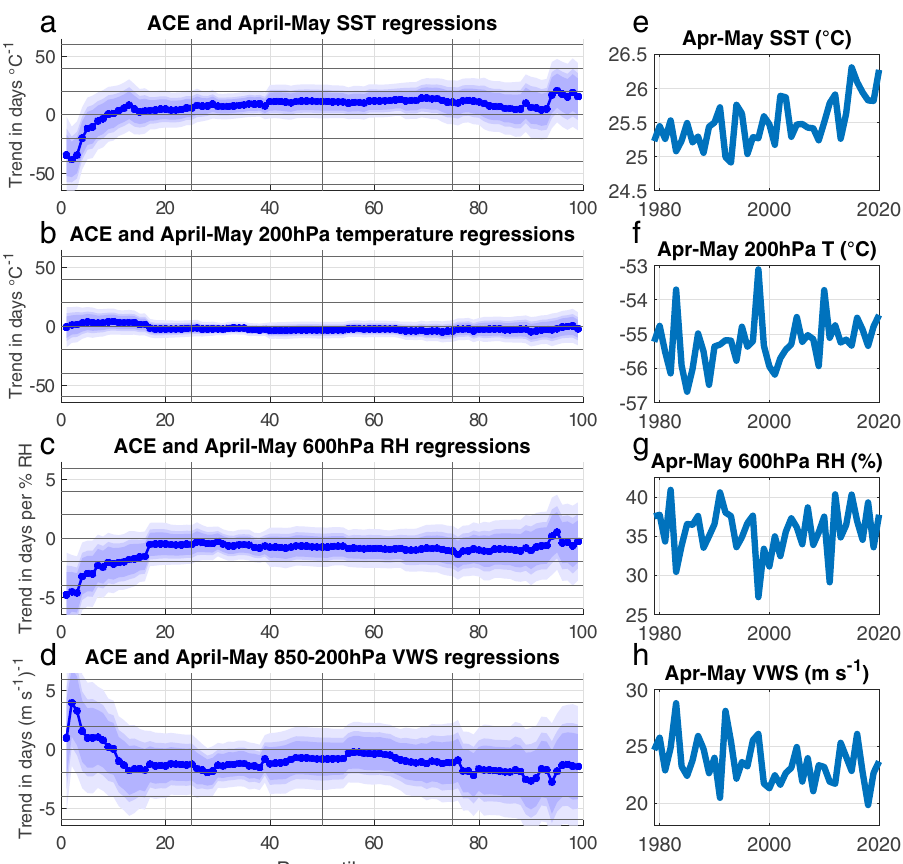
Fig. 3 Quantile regressions of Accumulated Cyclone Energy (ACE) with genesis parameters. Trends of Atlantic ACE 1st – 99th percentile threshold date between 1979 – 2020 in days per April – May mean ( a ) sea surface temperatures (SST; °C), ( b ) 200 hPa temperatures (°C), ( c ) 600-hPa relative humidity (RH; %), ( d ) 850-200-hPa vertical wind shear (VWS; m s − 1 ) over 10 – 36°N, 100 – 70°W. Mean values of April-May ( e ) ERSSTv5 SST (°C), ( f ) ERA5 200 hPa temperatures (°C), ( g ) ERA5 RH (%), and ( h ) ERA5 VWS (m s − 1 ) over 10 – 36°N, 100 – 70°W for 1979 – 2020. Light, medium, and dark blue shading in ( a – d ) indicates the 99%, 95%, and 90% con fi dence intervals, as in Fig.